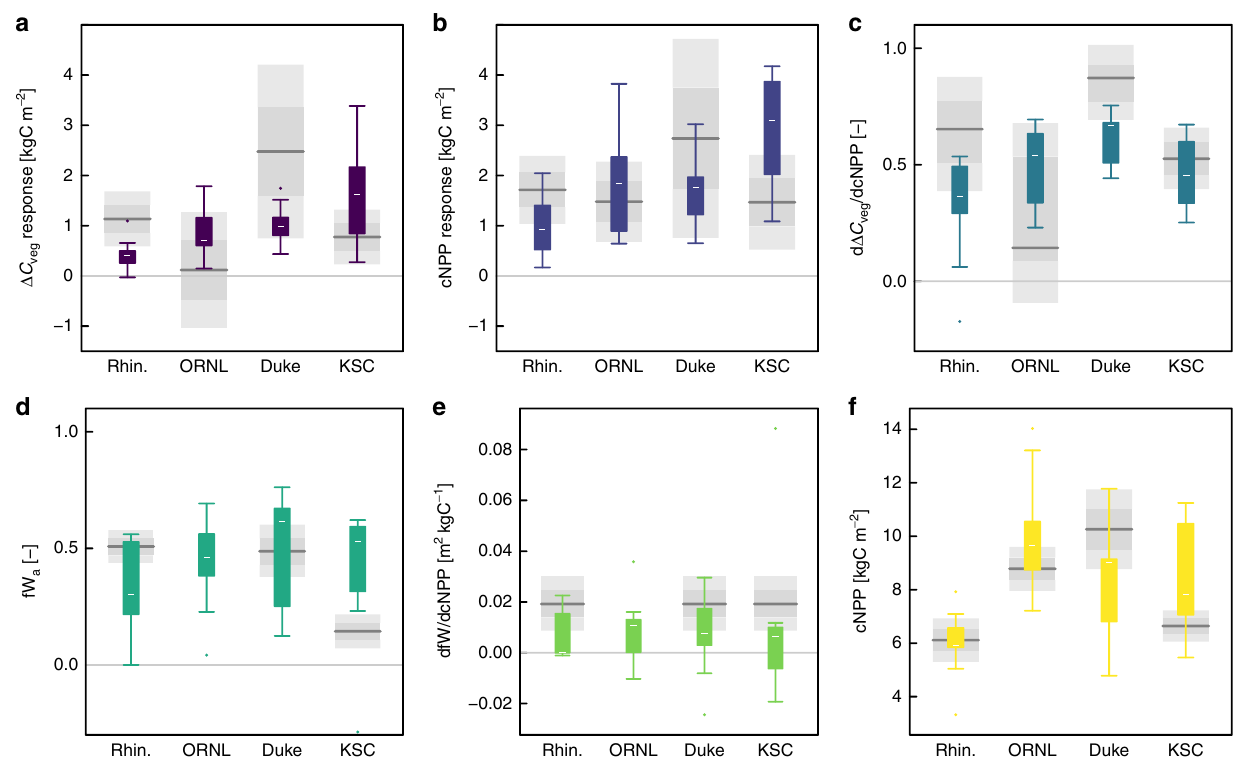
Fig. 4 Model ensemble predictions compared against observations. a the Δ C veg response to CO 2 enrichment. The key variables leading to the response — b the cNPP response to CO 2 enrichment and c d Δ C veg /dcNPP. And the three components of d Δ C veg /dcNPP — d fW a , e d fW /dcNPP and f cross-treatment mean cNPP. Coloured boxes and whiskers represent the model ensemble predictions (white bar is the median, the box the inter-quartile range, whiskers data within four times the IQR, and dots are outliers). Grey shaded areas represent the observations (dark grey lines are observed means or regression parameters, grey polygons are the SEM CI and the lighter grey polygons are the 95% CI). ORNL has no observed data on plots d and e as these were calculated from the regression of fW on cNPP. ORNL was not included as the regression was intended to explain the biomass retention rate, which was not signi fi cant at ORNL and was highly